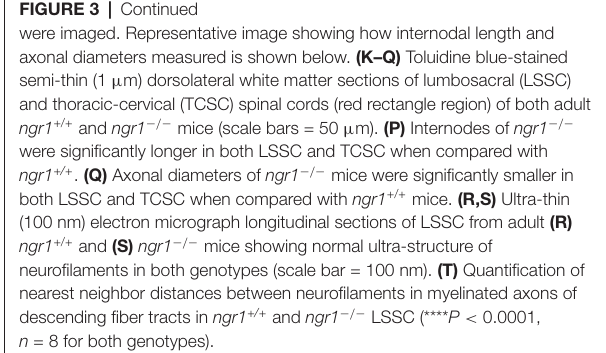
FIGURE 3 | Continued were imaged. Representative image showing how internodal length and axonal diameters measured is shown below. (K–Q) Toluidine blue-stained semi-thin (1 µ m) dorsolateral white matter sections of lumbosacral (LSSC) and thoracic-cervical (TCSC) spinal cords (red rectangle region) of both adult ngr1 +/+ and ngr1 − / − mice (scale bars = 50 µ m). (P) Internodes of ngr1 − / − were significantly longer in both LSSC and TCSC when compared with ngr1 +/+ . (Q) Axonal diameters of ngr1 − / − mice were significantly smaller in both LSSC and TCSC when compared with ngr1 +/+ mice. (R,S) Ultra-thin (100 nm) electron micrograph longitudinal sections of LSSC from adult (R) ngr1 +/+ and (S) ngr1 − / − mice showing normal ultra-structure of neurofilaments in both genotypes (scale bar = 100 nm). (T) Quantification of nearest neighbor distances between neurofilaments in myelinated axons of descending fiber tracts in ngr1 +/+ and ngr1 − / − LSSC (**** P < 0.0001, n = 8 for both